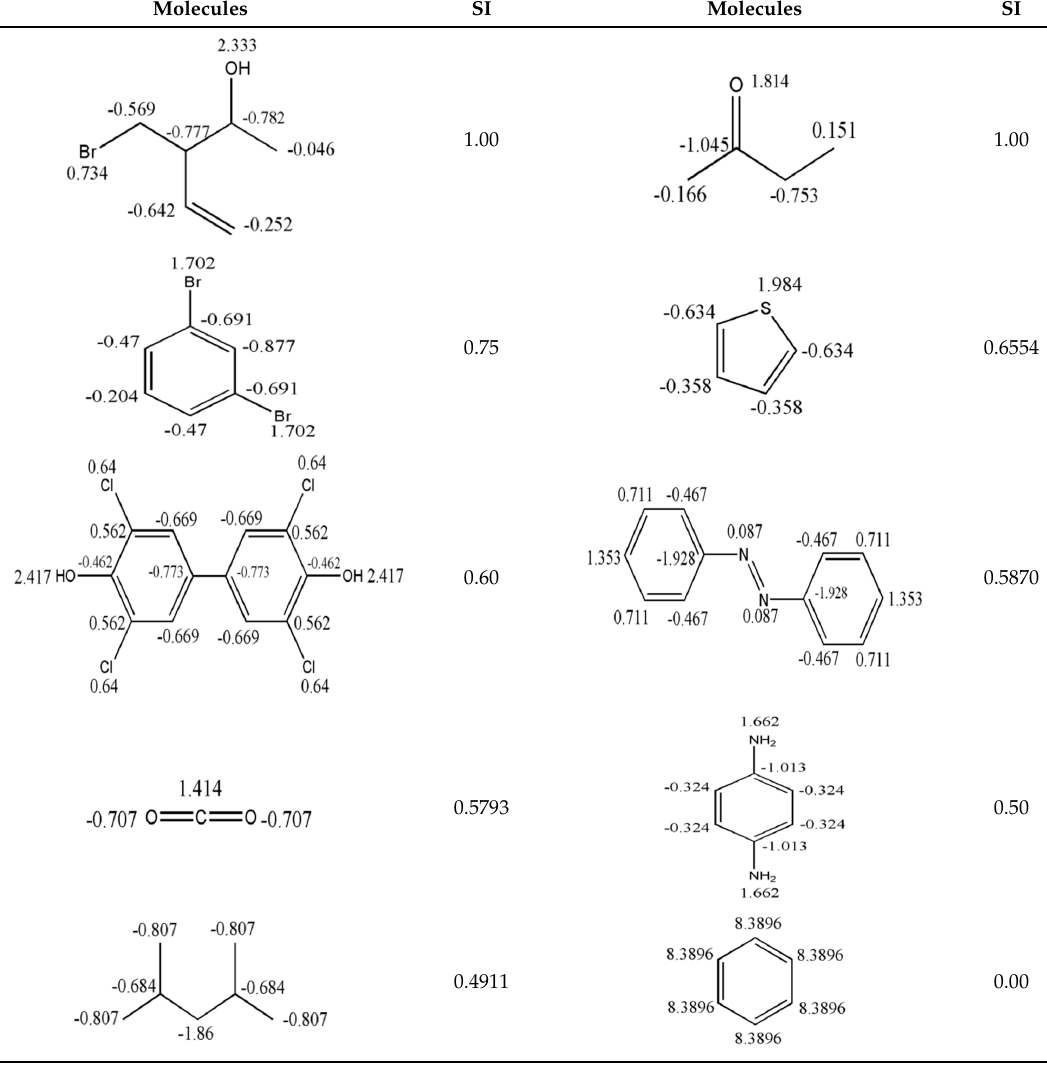
Table 6. Symmetry Index for some organic molecules.